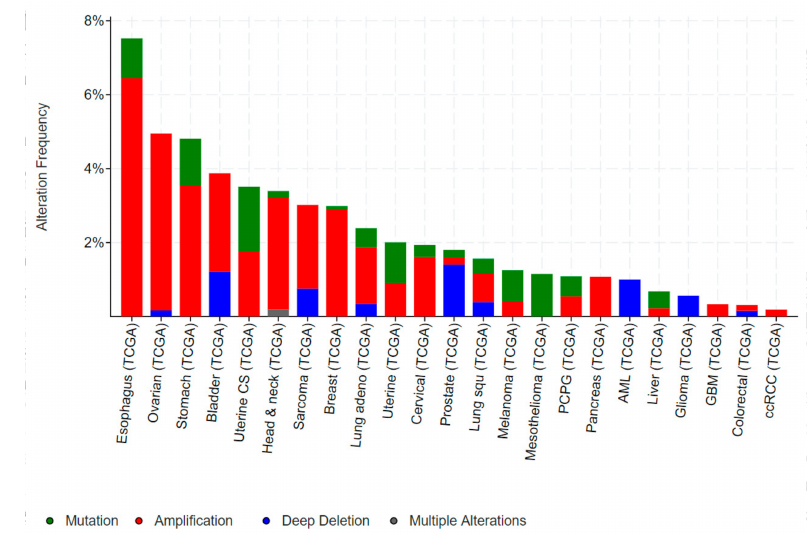
Figure 8. Genomic alterations in EHF in human cancers. Data from cancer bioportal. Only showing cancers in which >50 cases were